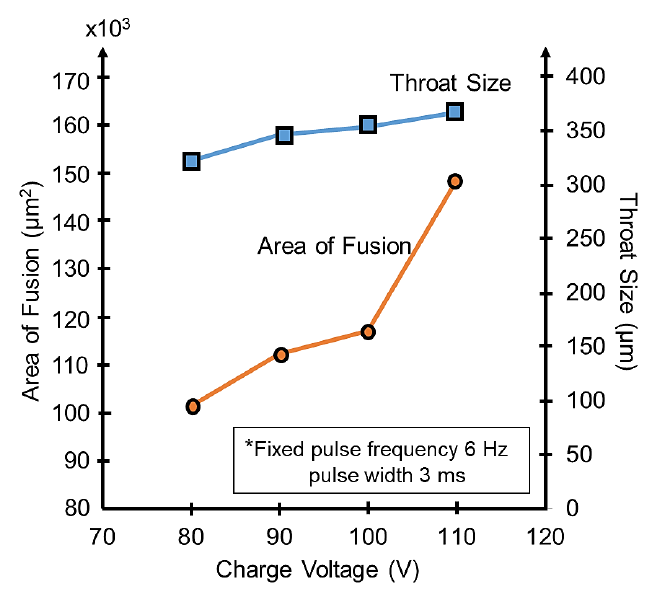
Figure 12. Effect of charge voltage on area of fusion and throat size.